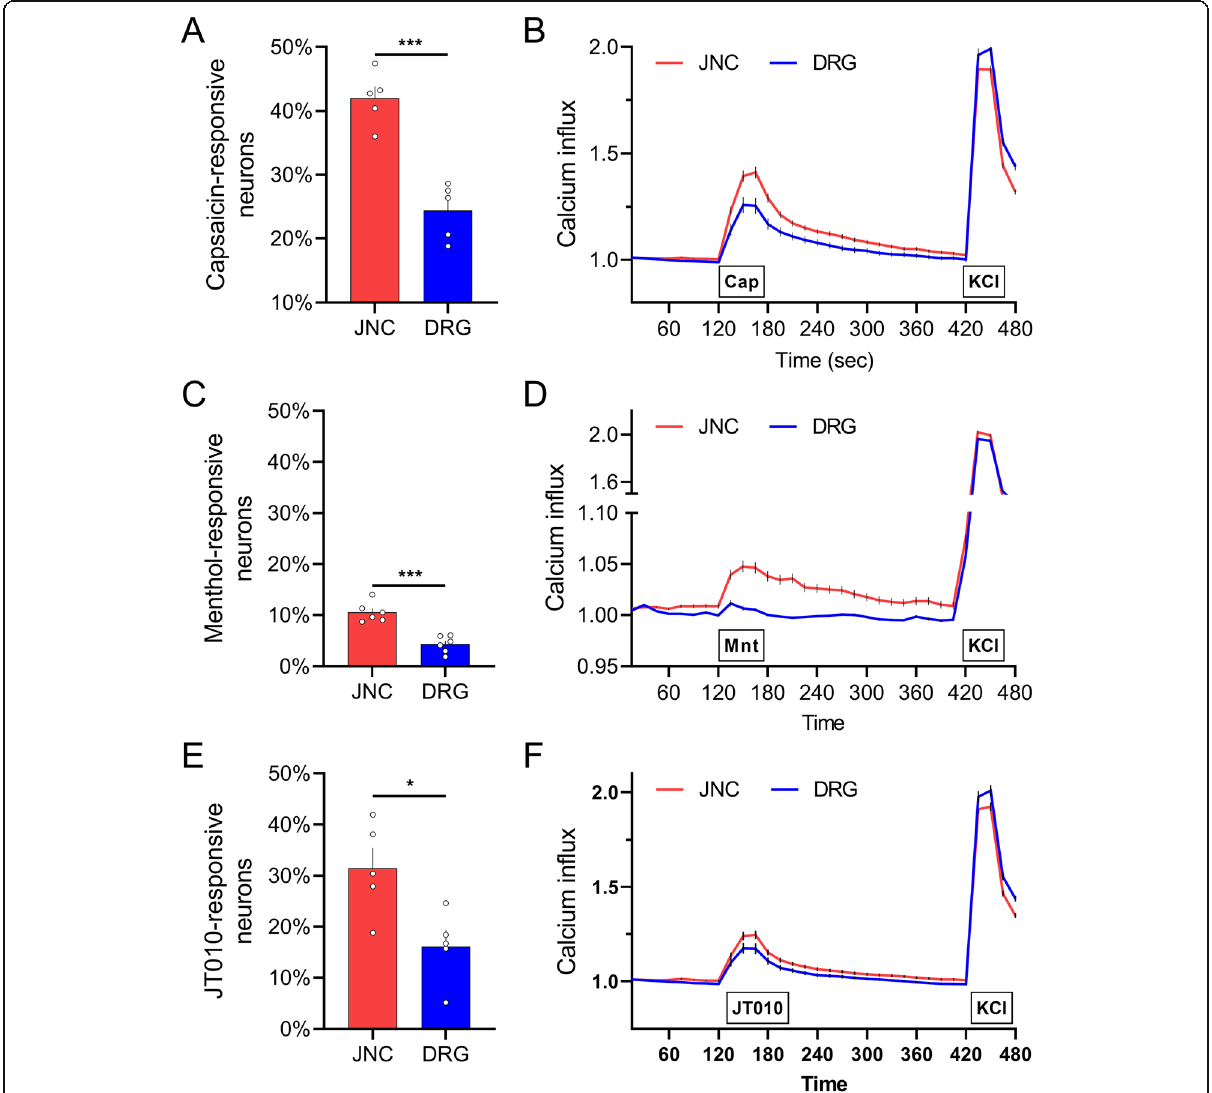
Fig. 2 JNC neurons are more sensitive to TRPV1, TRPA1 and TRPM8 stimulation. Naïve C57BL/6 mouse JNC and DRG neurons were harvested, cultured (2,500 neurons/plate) for 24h, loaded with a calcium responsive dye (Fura-2AM), and sequentially exposed to the TRPV1 agonist capsaicin (300nM; A-B ), the TRPA1 agonist menthol (100uM; C-D ), or the TRPA1 agonist JT010 (1uM, E-F ) followed by KCl (40mM; positive control; A-F ). The number of responsive ( A, C, E ) cells to capsaicin, menthol, and JT010 is increased in JNC neurons. The average amplitude of responses are shown in ( B, D, F ). Data are shown as mean ± S.E.M. Number of dishes tested is shown. N are as follows: A-C-E : n=5-6 dishes/group , B-D-F : n=290-1200 neurons/group. P-values are shown in the figure and determined by unpaired Student's t-test ( A, C, E